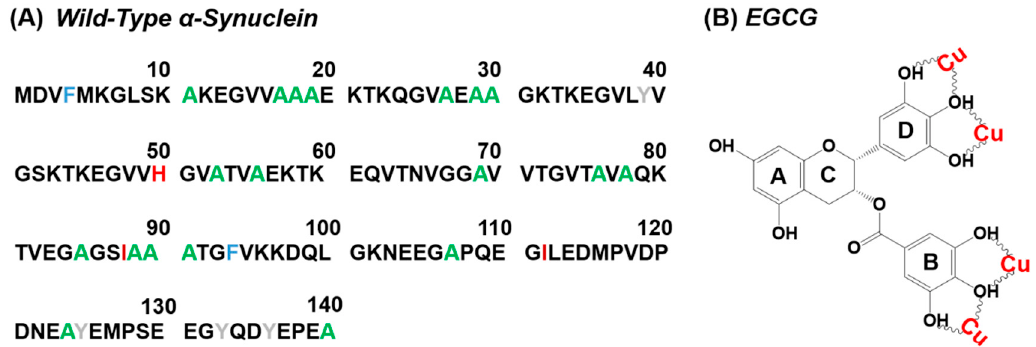
Figure 1. ( A ) Sequences of wild-type human α -Syn. ( B ) Structure of EGCG, and the potential Cu(II) binding sites in EGCG [19].